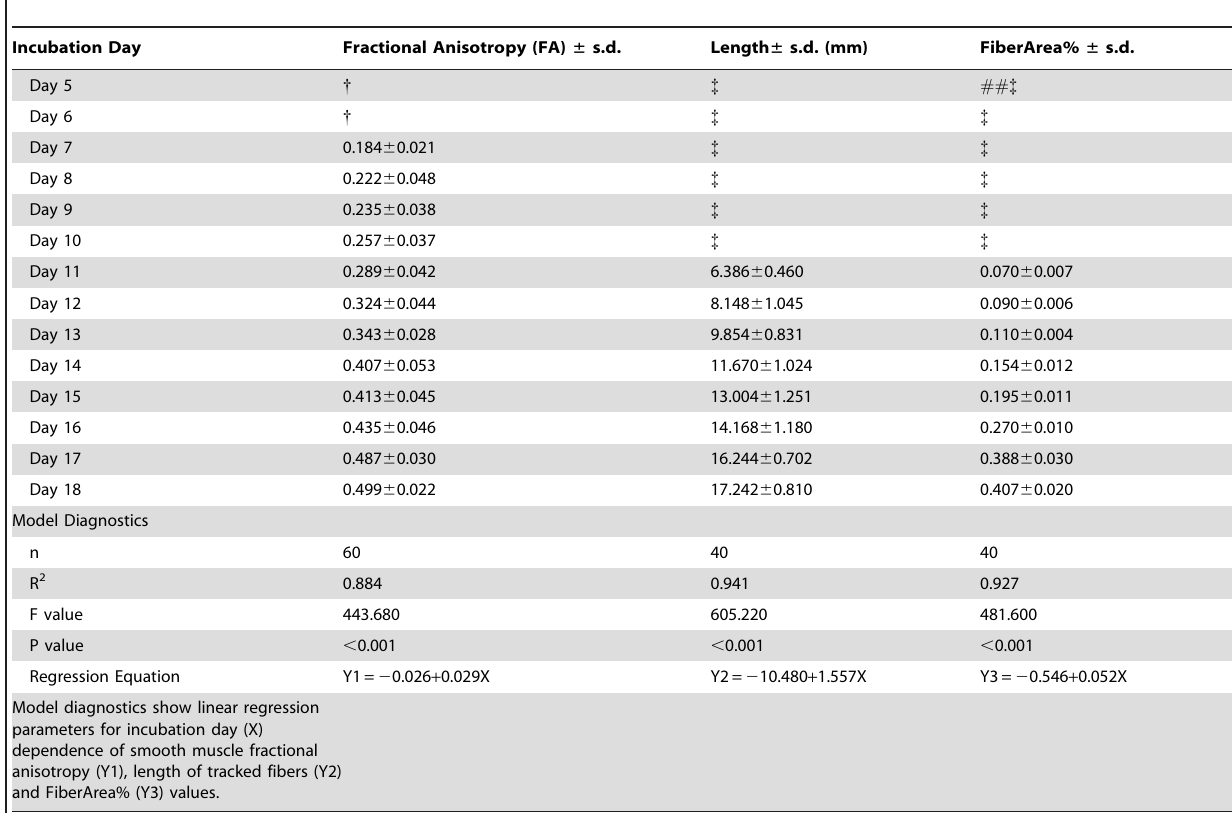
Table 1. Smooth muscle fractional anisotropy, tracked fiber length and FiberArea% values for chick embryonic gizzard at each day of incubation.